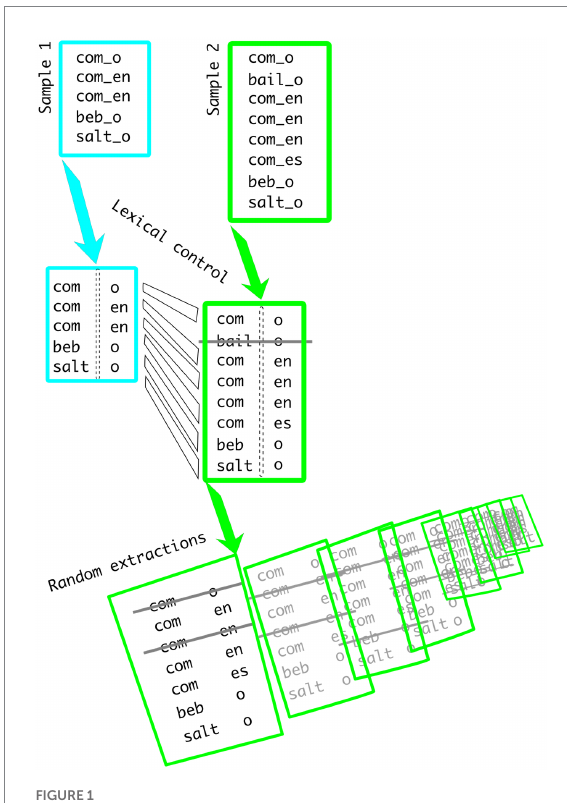
FIGURE 1 Example of the lexical and sampling controls used by EsLiPro.